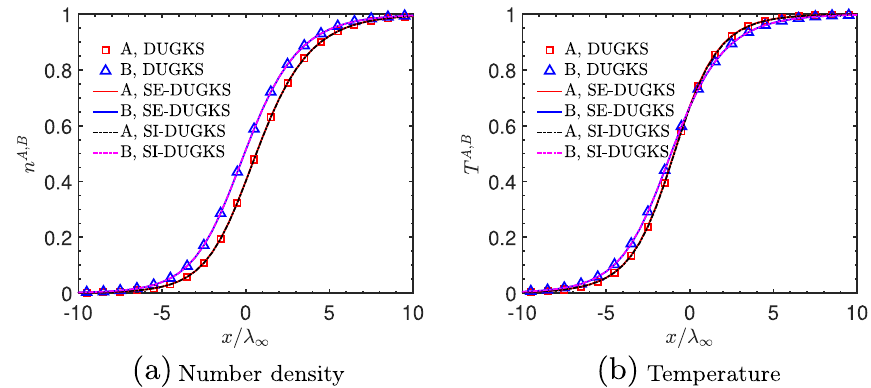
Fig. 2 Shock structure with Ma − = 1.5 , m B ∕ m A = 0.5 , and 𝜒 A = 0.1